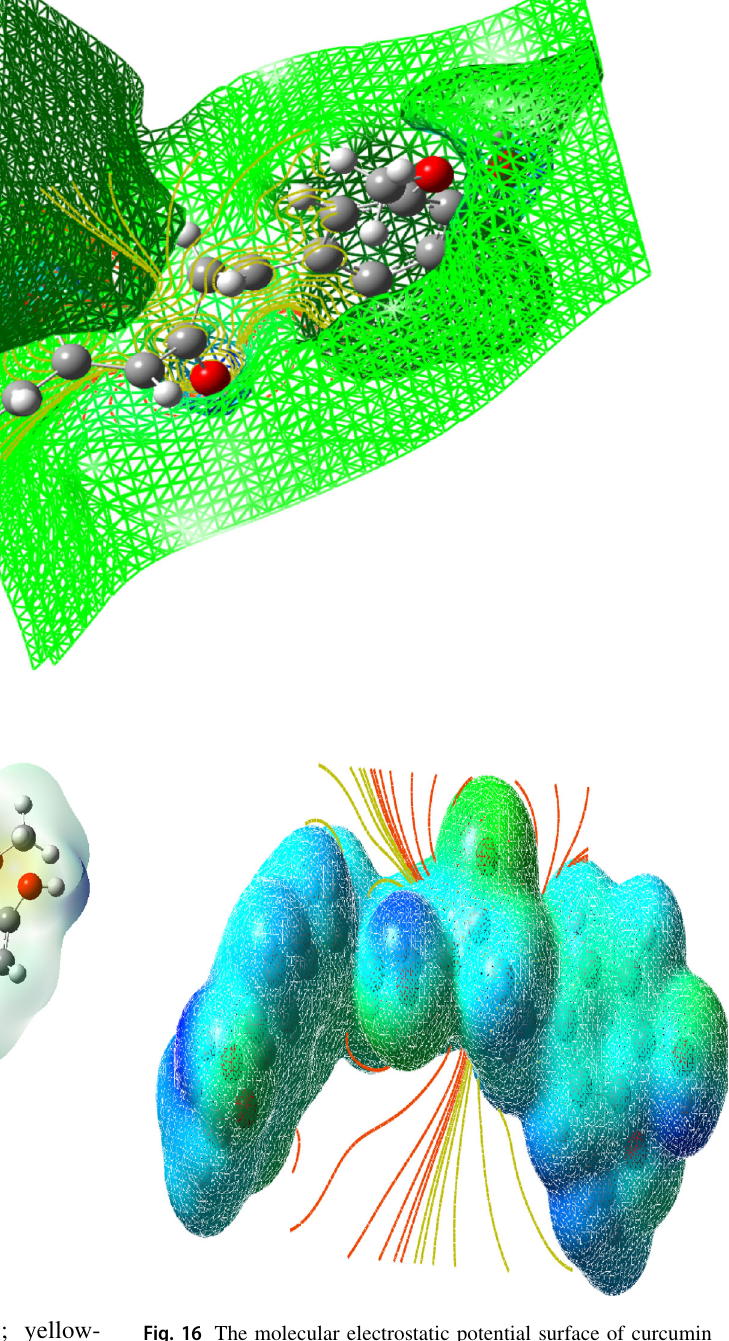
Fig. 16 The molecular electrostatic potential surface of